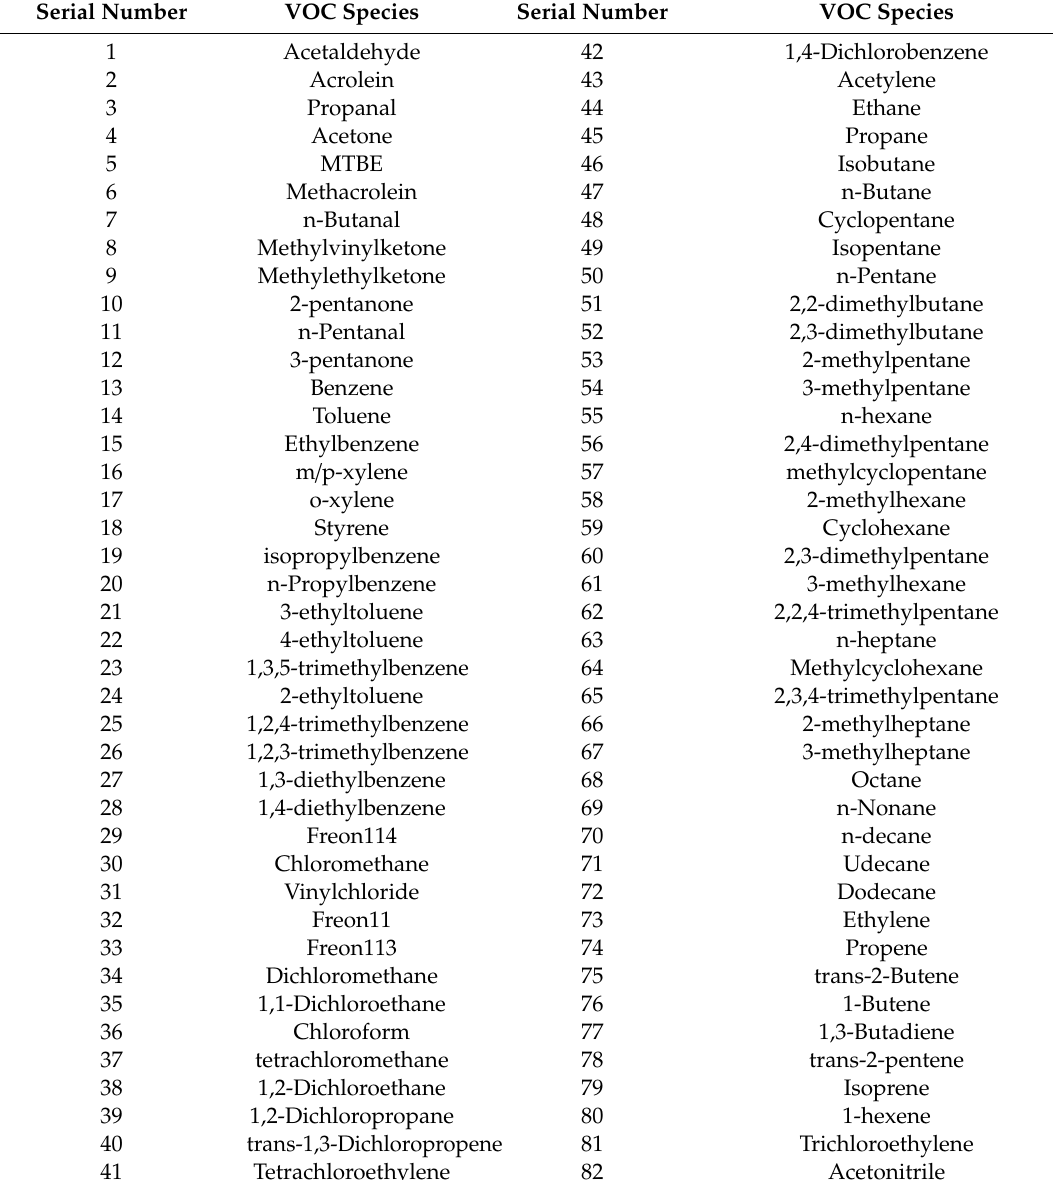
Table 2. VOCs species applied in the PMF